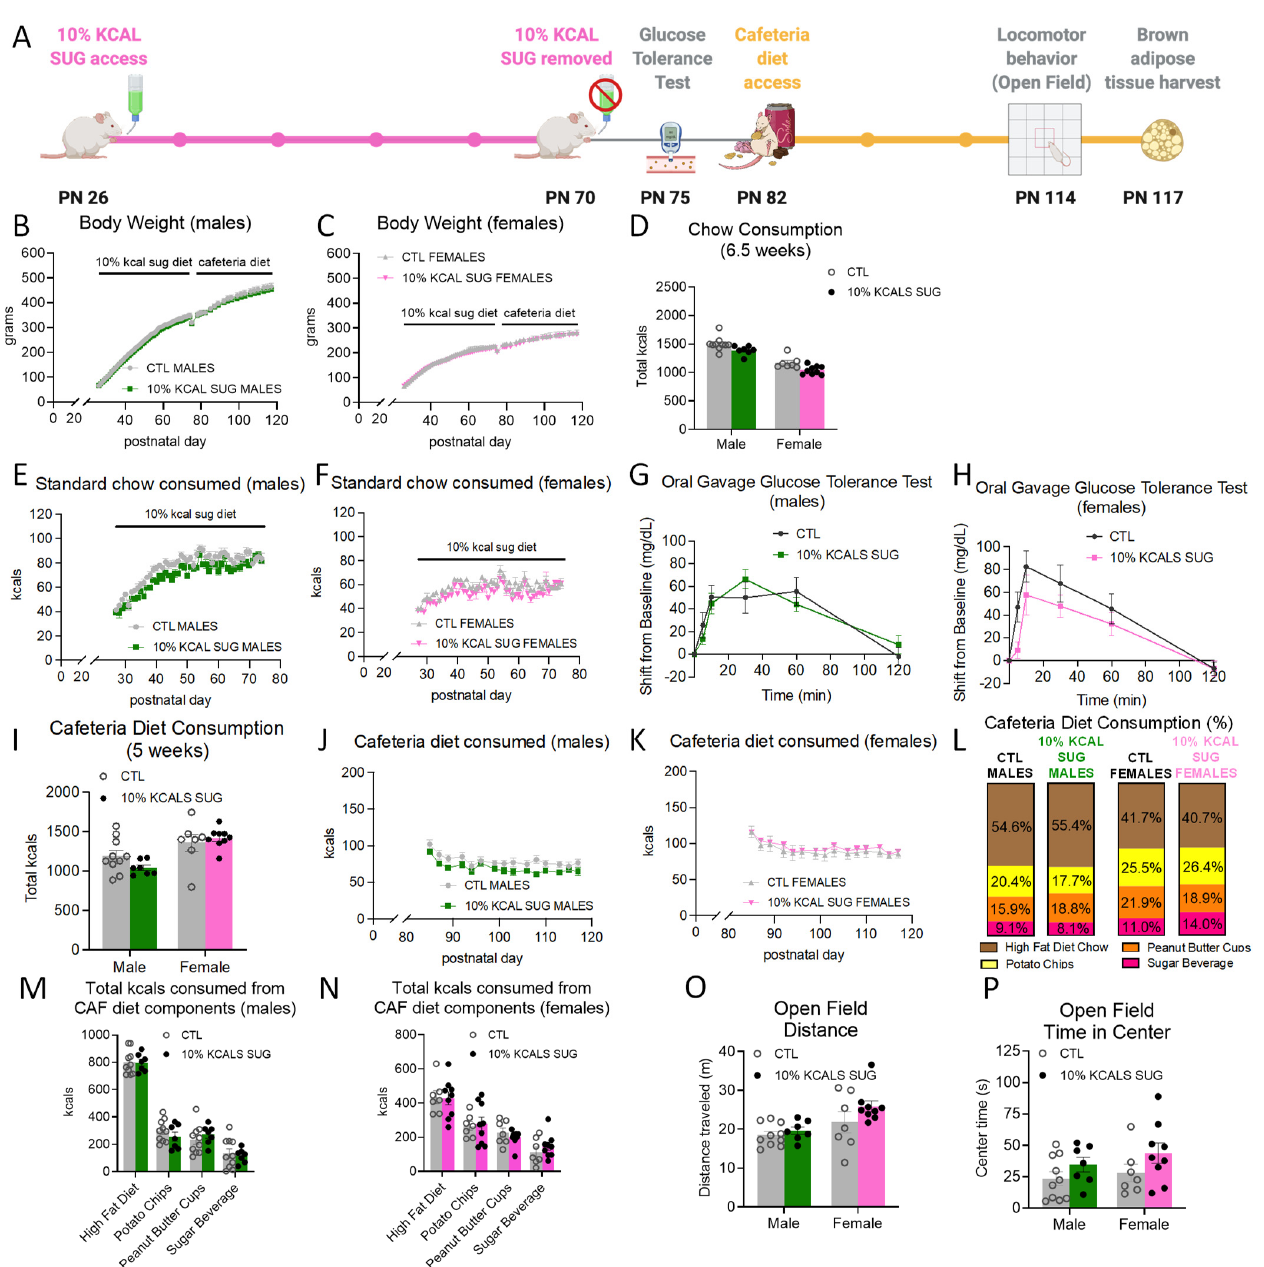
Figure 2. Effects of early life consumption of sugar at 10% of total calories consumed on energy balance parameters during adulthood. Limiting the consumption of sugar to 10% of the total calories consumed during the juvenile and adolescent periods ( A ) had no effect on body weight ( B , C ), chow intake ( D – F ), glucose tolerance ( G , H ), cafeteria diet consumption ( I – N ), locomotor activity ( O ), or anxiety-like behavior ( P ) relative to controls that did not have sugar access during adolescence. Data are represented as mean ± SEM; PN: postnatal day; CAF: cafeteria; CTL: control; SUG: sugar; kcal: kilocalories.